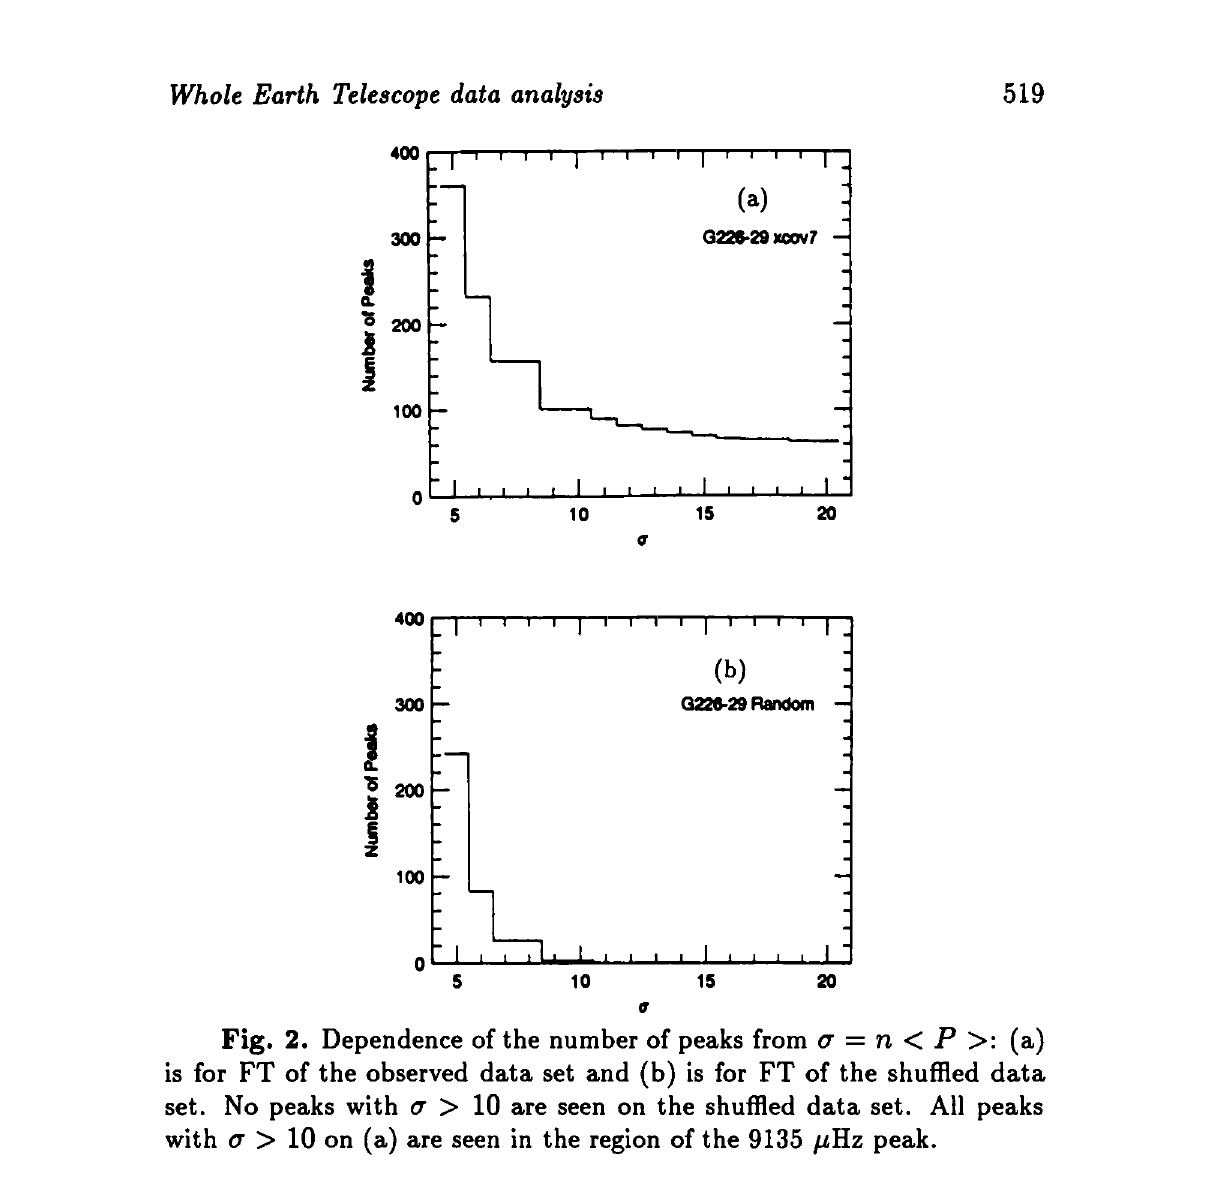
Fig. 2. Dependence of the number of peaks from a = n < P >: (a) is for FT of the observed data set and (b) is for FT of the shuffled data set. No peaks with a > 10 are seen on the shuffled data set. All peaks with a > 10 on (a) are seen in the region of the 9135 /¿Hz